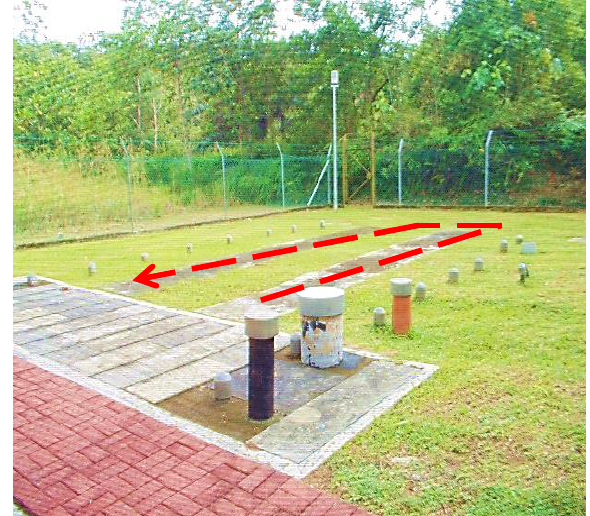
Figure 2 . Utility mapping calibration area